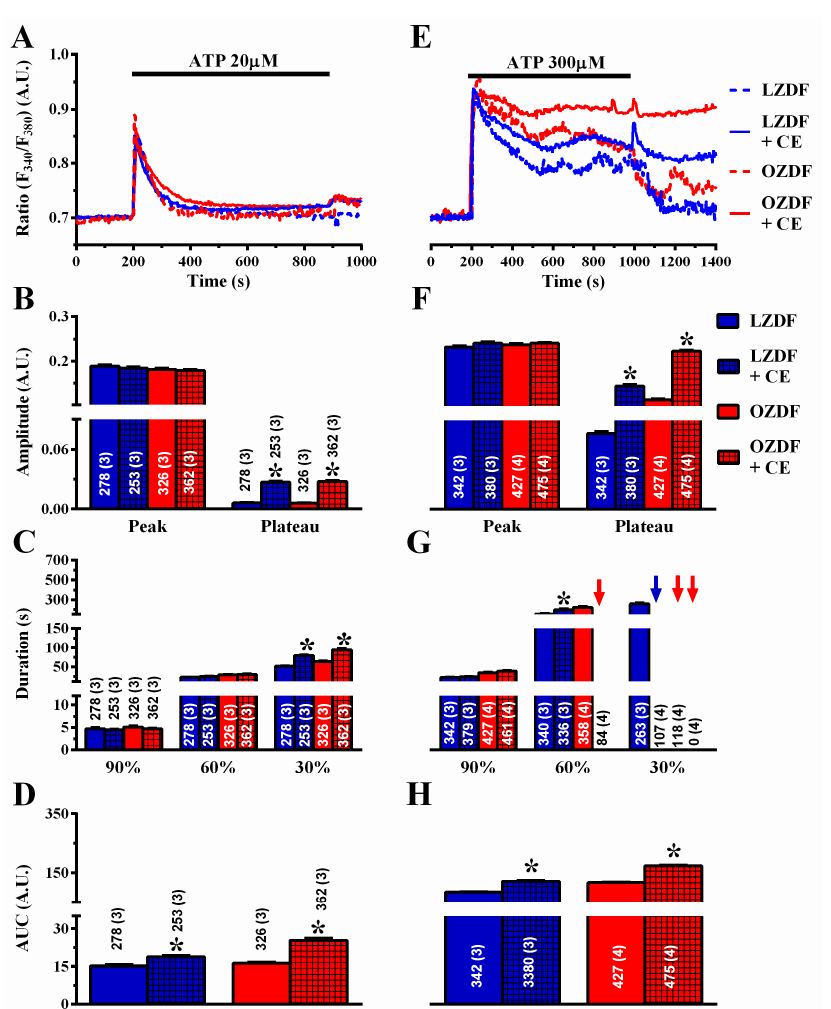
Figure 8. The e ff ect of carboxyeosin on the Ca 2 + response to ATP is unaltered in native aortic endothelium of obese Zucker diabetic fatty rats. ( A ) Representative recordings of the Ca 2 + response to 20 µ M ATP in the absence or presence of 20 µ M carboxyeosin (CE) in native aortic endothelium of LZDF and OZDF rats. Excised rat aorta was preincubated for 500 s with 20 µ M CE before ATP addition. ( B ) Mean ± SE of endogenous Ca 2 + release and SOCE amplitude recorded in native aortic endothelium of LZDF and OZDF rats challenged with 20 µ M ATP in the absence or presence of 20 µ M CE. ( C ) Mean ± SE of the duration of the Ca 2 + response to 20 µ M ATP recorded in native aortic endothelium of LZDF and OZDF rats in the absence or presence of 20 µ M CE. ( D ) Mean ± SE of the AUC of the two distinct components (i.e., endogenous Ca 2 + release and SOCE) of the Ca 2 + response to 20 µ M ATP recorded in native aortic endothelium of LZDF and OZDF rats in the absence or presence of 20 µ M CE. ( E ) Representative recordings of the Ca 2 + response to 300 µ M ATP in the absence or presence of 20 µ M CE in native aortic endothelium of LZDF and OZDF rats. ( F ) Mean ± SE of endogenous Ca 2 + release and SOCE amplitude recorded in native aortic endothelium of LZDF and OZDF rats challenged with 300 µ M ATP in the absence or presence of 20 µ M CE. The asterisk indicates p < 0.05. ( G ) Mean ± SE of the duration of the two distinct components (i.e., endogenous Ca 2 + release and SOCE) of the Ca 2 + response to 300 µ M ATP in native aortic endothelium of LZDF and OZDF rats in the absence or presence of 20 µ M CE. The asterisk indicates p < 0.05. Blue and red arrows indicate that the Ca 2 + signal failed to reach the clearing rate indicated in the graph in LZDF and OZDF rats respectively. ( H ) Mean ± SE of the AUC of the two distinct components (i.e., endogenous Ca 2 + release and SOCE) of the Ca 2 + response to 300 µ M ATP in native aortic endothelium of LZDF and OZDF rats in the absence or presence of 20 µ M CE. The asterisk indicates p < 0.05, Mann-Whitney